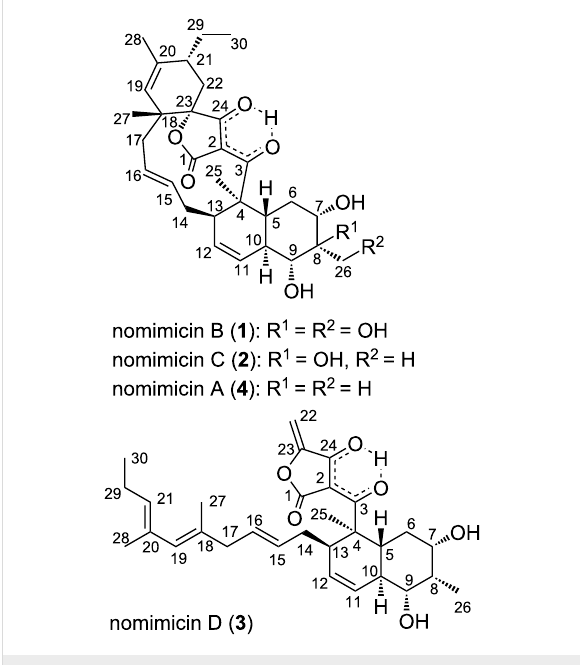
Figure 1: Structures of nomimicins A–D ( 4 and 1 – 3 ).